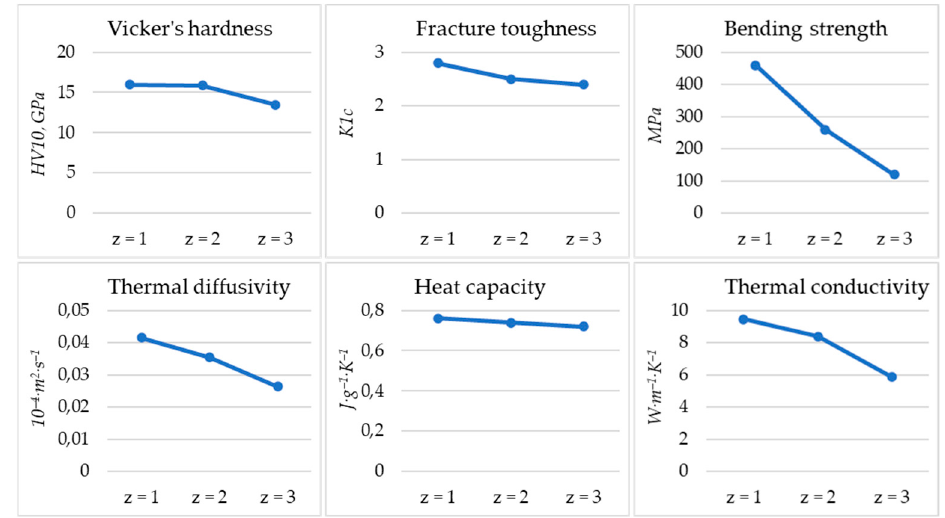
Figure 6. Mechanical and physical properties of β -SiAlONs depending on the z value (according to literature data